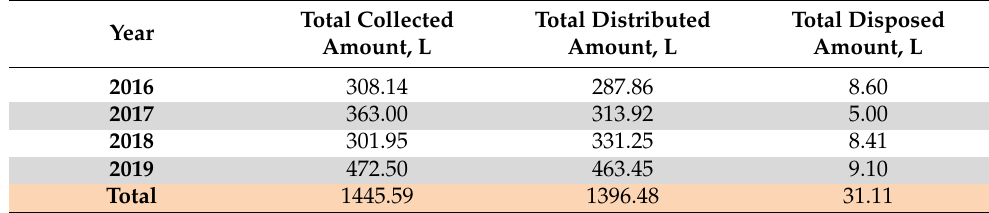
Table 1. Amounts of milk collected in Regional Human Milk Bank (RHMB) in Warsaw per year.